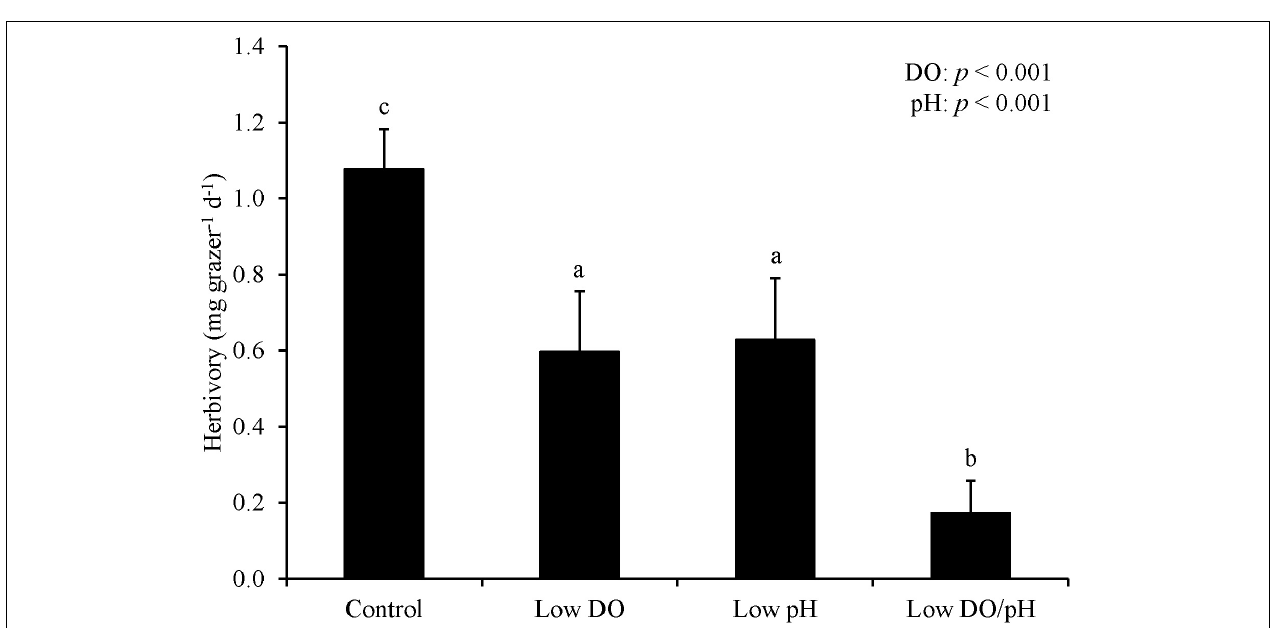
FIGURE 1 | Herbivory rates of L. vincta grazing on U . rigida with initial starvation under control (ambient pH/DO), low DO, low pH, and low pH/DO (Experiment 1; Table 2 ). Columns represent means ± standard deviation. Statistical analyses: Two-way ANOVA and post hoc Tukey Honest Significant Difference tests performed; significant differences between treatments represent p -values less than